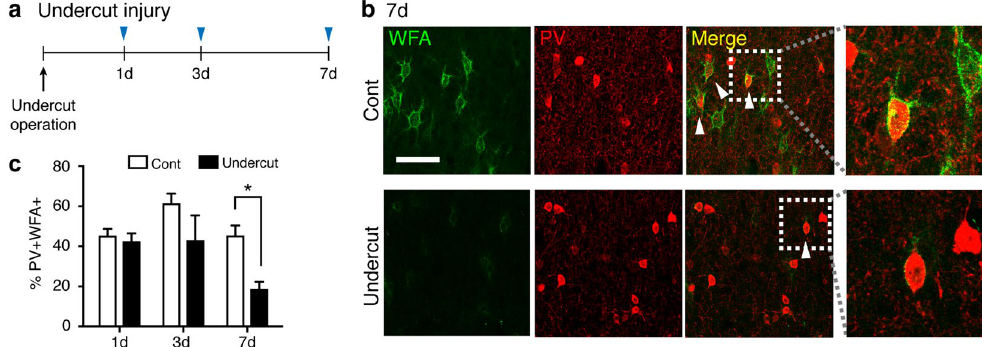
Figure 3. Perineuronal nets around PV( + ) interneurons are degraded following traumatic brain injury. ( a ) Time line of experimental design. ( b ) Representative confocal images of rat undercut and contralateral (Cont) cortices stained for parvalbumin (PV) and perineuronal nets using Wisteria Floribunda agglutinin (WFA) 7 days after the operation. Scale bar = 50 µ m. White arrowheads indicate representative PV( + )/WFA( + ) cells. Areas within white rectangles in merged images are shown magnified. ( c ) The percentage of PV( + ) interneurons associated with PNNs was significantly decreased at 7 days following the undercut operation. * p < 0.05, Two-way ANOVA with post-hoc Sidak’s test, two tailed. Three biological replicates (n’s = 3) were used at each time